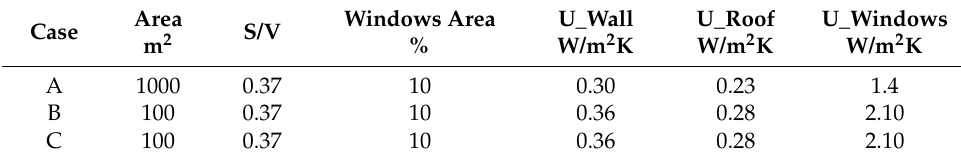
Table 2. Specifications of building properties [62,63].